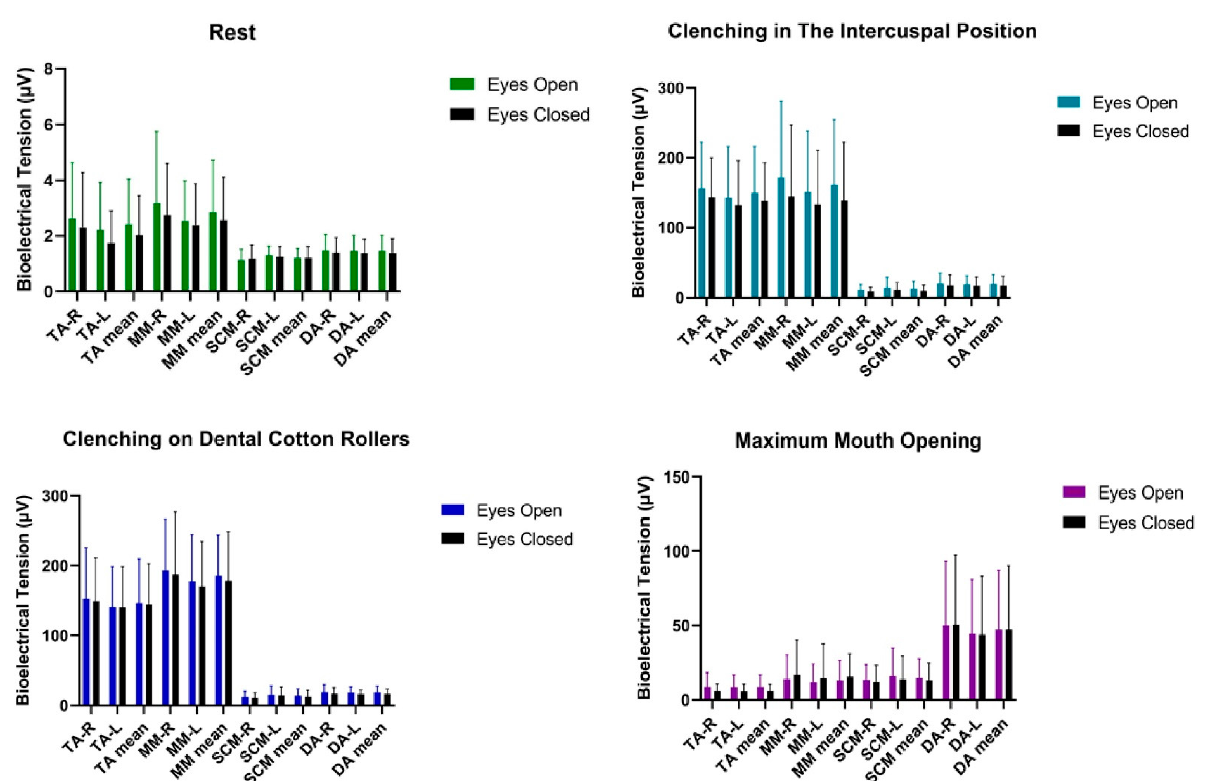
Figure 4. Graphical representation of bioelectrical activity of selected muscles of the masticatory and cervical spine muscles in men. TA—the anterior part of the temporalis muscle; MM—the superficial part of the masseter muscle; SCM—the middle part of the sternocleidomastoid muscle; DA—the anterior belly of the digastric muscle; R—right site; L—left site. Statistical analysis of AcI and AsI patterns conducted on a group of men showed that there were no significant statistical differences in the tested muscle activities of TA, MM, SCM, DA between the tests (Table 5 and Figure 5). Table 5. Results of comparison of bioelectrical patterns of selected muscles of the masticatory and cervical spine muscles in men. Closed Eye